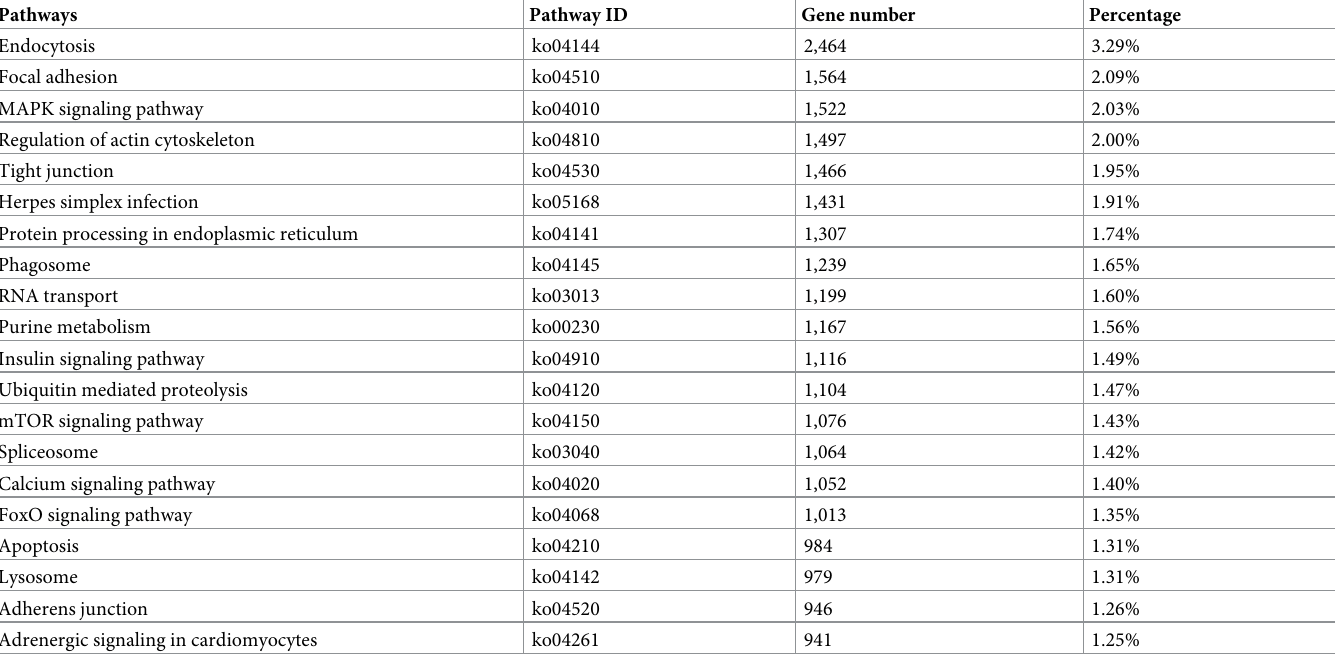
Table 4. The top 20 mapped pathways annotated by the KEGG database.